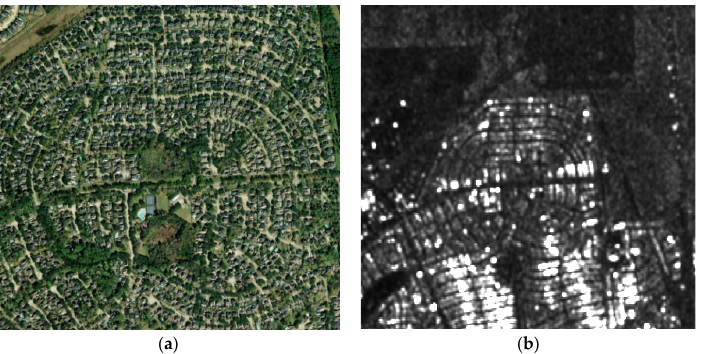
Figure 2. The curved-arrangement residential cluster and its radiation intensity in SAR image. ( a ) The Google optical image of the curved-arrangement residential cluster. ( b ) The scattering inten- sity of GRD (ground range detected) data of Sentinel-1B, corresponding to ( a ).